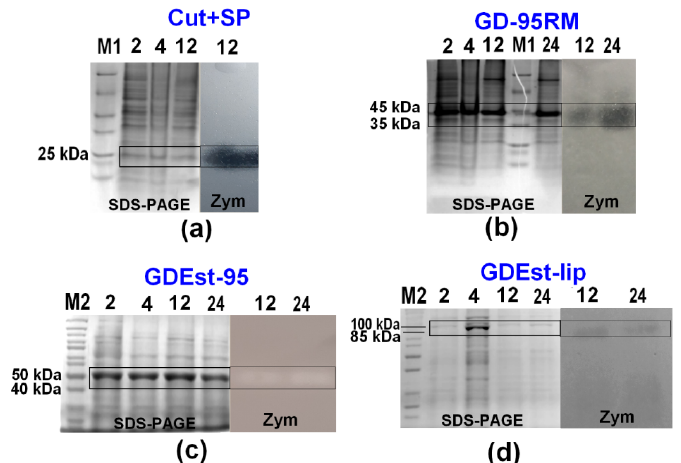
Figure 7. Activity analysis of recombinant Cut+SP ( a ), GD-95RM ( b ), GDEst-95 ( c ), and GDEst-lip ( d ) enzymes in zymograms (Zym) during production in 2 L mM9 cultivation medium without additional supplementation with ampicillin and using MP (4 mM) as an inducer. M1—Pierce™ Unstained Protein MW Marker; M2—PageRuler™ Unstained Protein Ladder; 2/4/12/24—time point after induction with MP (in hours). The target enzymes are marked with black boxes. Tricine-SDS-PAGE was used for Cut+SP analysis, and glycine-SDS-PAGE for GD-95RM, GDEst-95, and GDEst-lip.